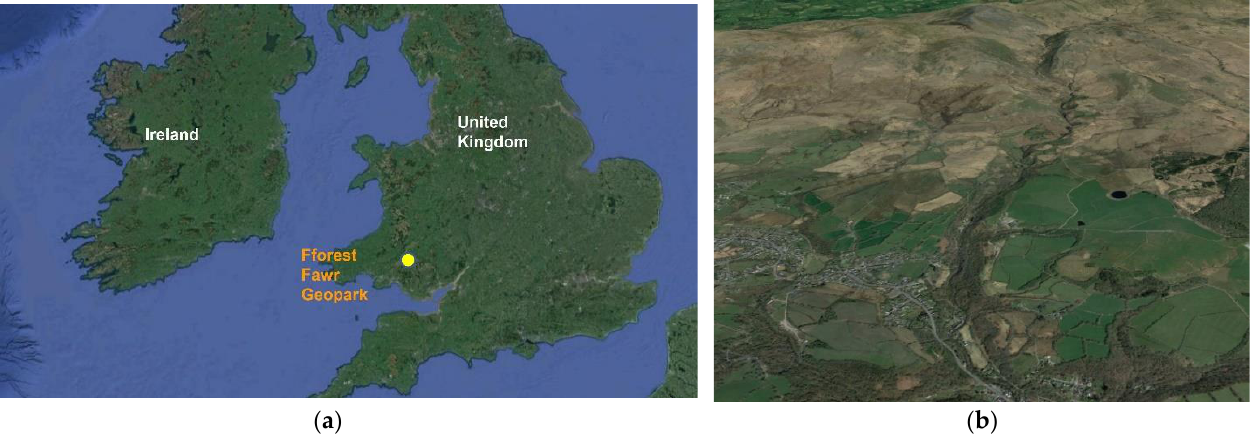
Figure 19. ( a ) The Adamello Brenta Park in the Italian territory (from Google Earth Pro V 7.3.4,